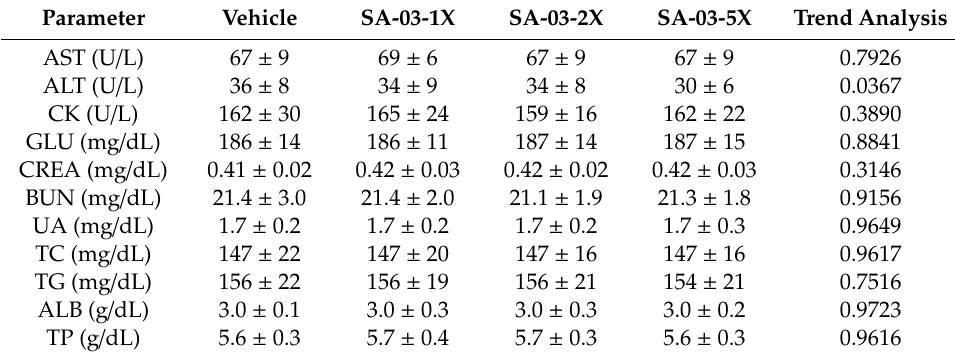
Table 3. Effects of SA-03 on biochemical parameters.